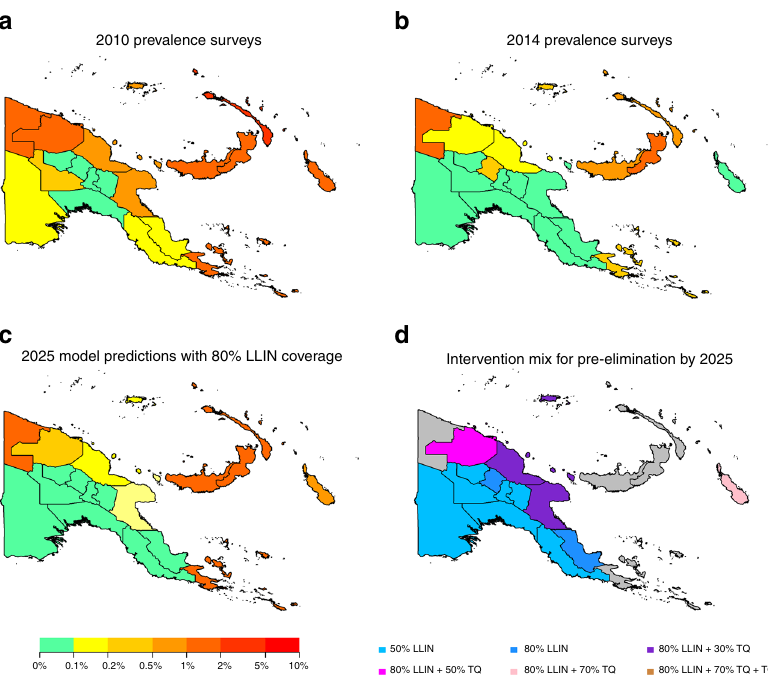
Fig. 4 Predicted impact of combinations of interventions in Papua New Guinea. Model predictions are based on the median of 100 stochastic simulations. a , b Estimated Pv PR LM in Papua New Guinea provinces based on household surveys from 2010 and 2014. c Model-predicted prevalence in 2025 under a scenario where LLINs are distributed every 3 years at 80% coverage levels. d Combinations of interventions required to obtain pre-elimination (de fi ned as prevalence < 0.1%) by 2025. Grey shading indicates that the interventions considered were predicted not to be suf fi cient to reduce prevalence to